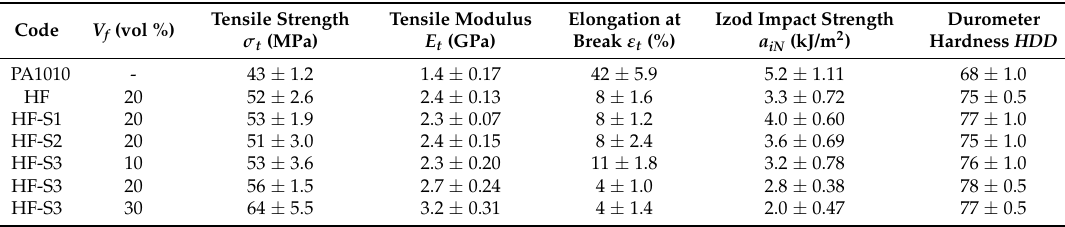
Table 3. Mechanical properties of various surface-treated HF/PA1010 biomass composites with silane coupling